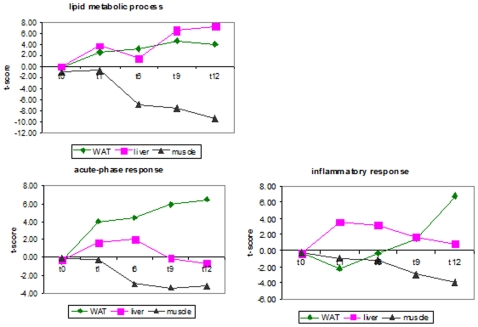
Analysis of biological processes in liver, WAT and muscle over time.Response profiles of specific biological processes are shown together with their average t-scores.